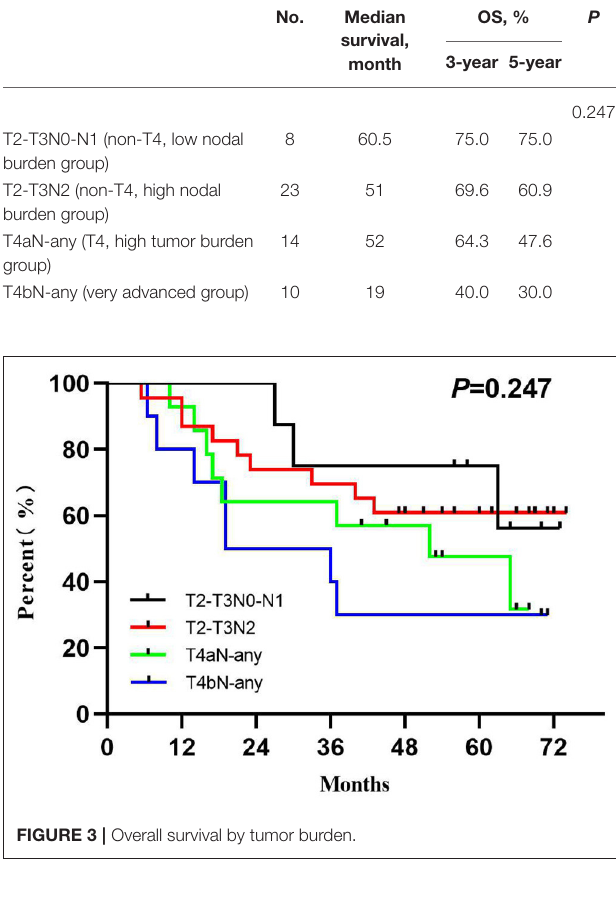
TABLE 2 | Survival analysis by tumor and node classification.